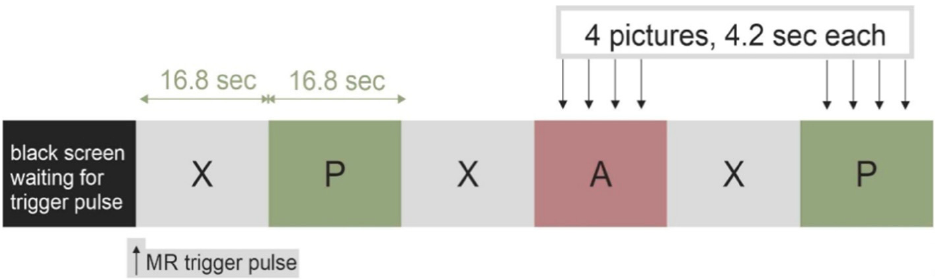
Figure 1. The task-based functional magnetic resonance imaging (fMRI) visual paradigm used in the TAKINSULA study, which presented 24 positive (P) and 24 aversive (A) pictures from the International Affective Picture System (IAPS) in a block design together with a fixation cross